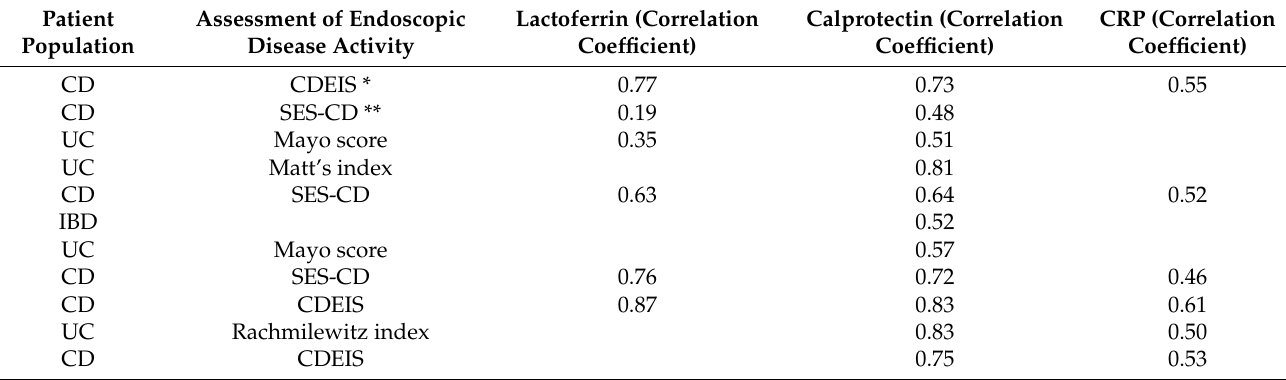
Table 1. Correlation of biomarkers with disease activity, determined by endoscopy.